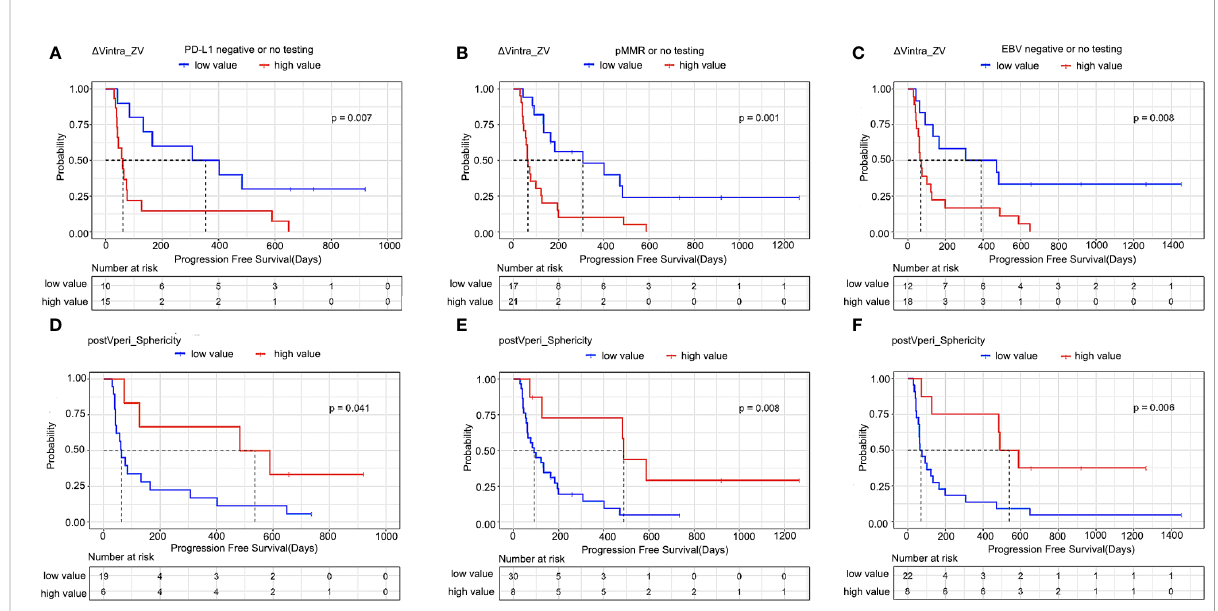
FIGURE 4 Kaplan – Meier estimates of progression-free survival in patients who had either not been tested or had already tested negative for biomarkers. (A, D) PD-L1, (B, E) MMR, and (C, F) EBV according to radiomics features. D Vintra_ZV, D Vintra_original_glszm_Zone Variance; postVperi_Sphericity,